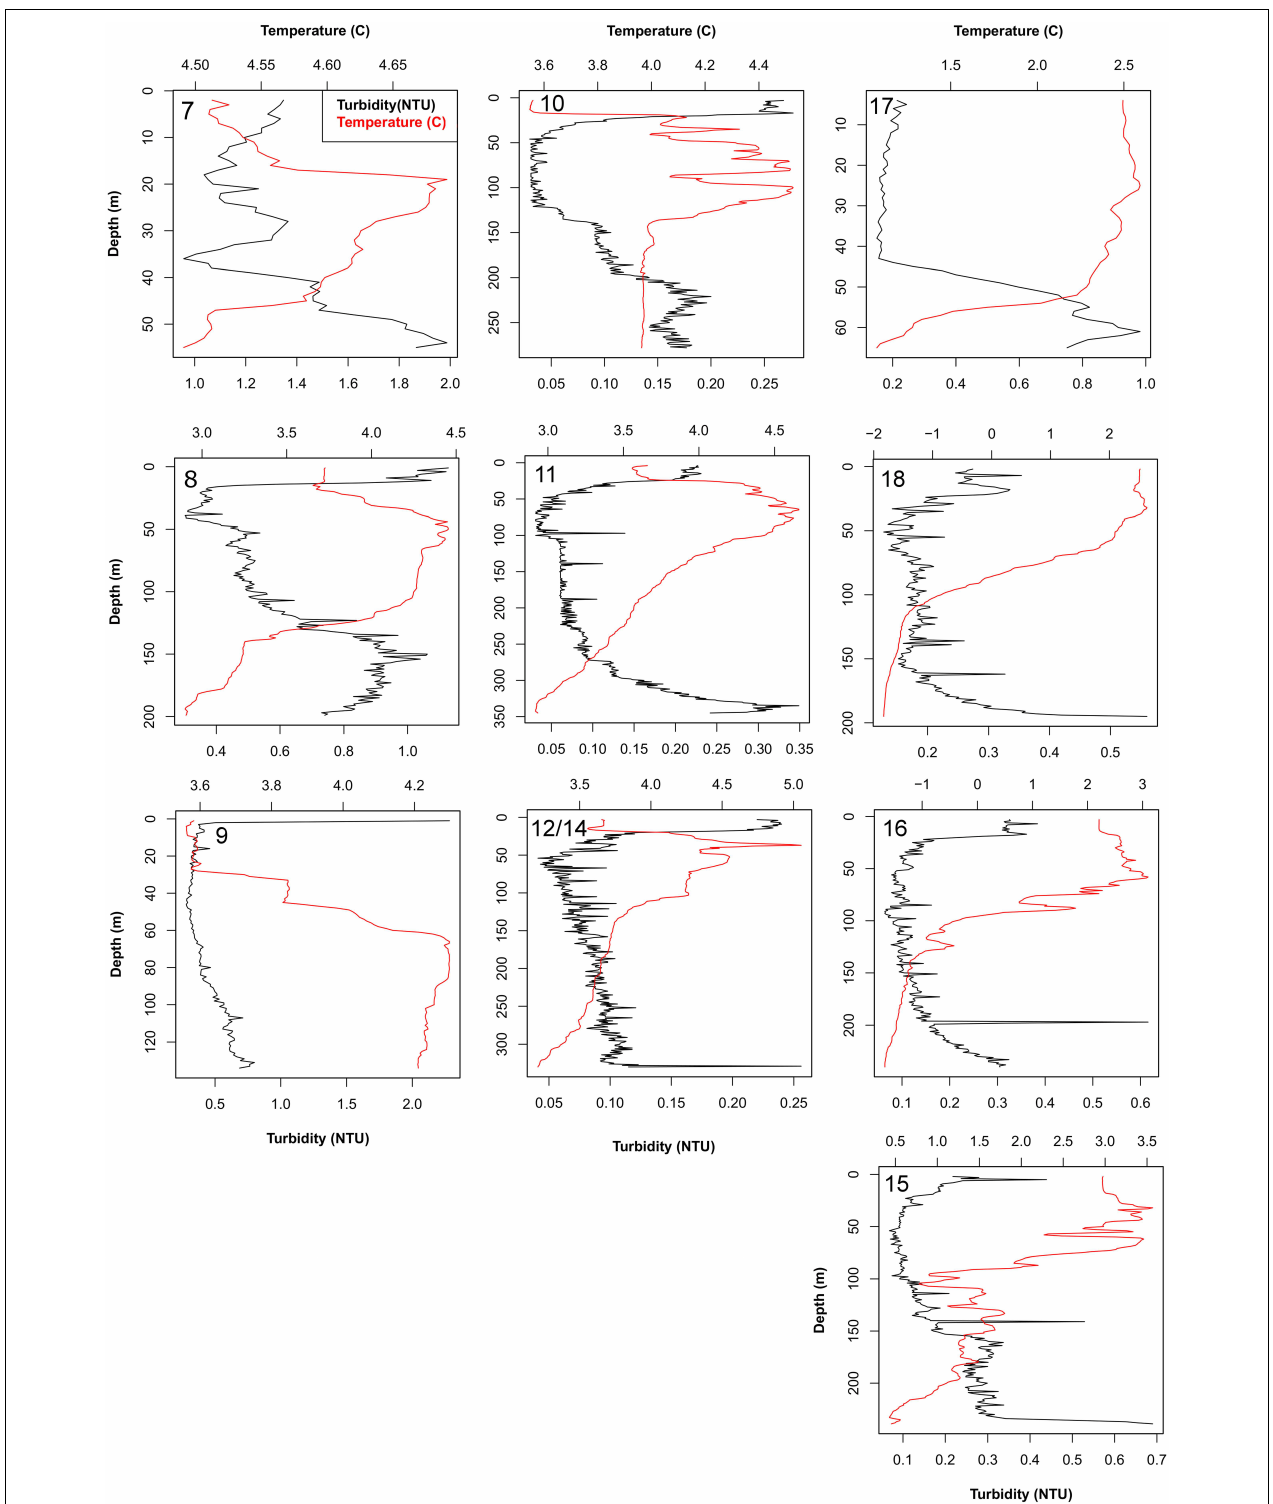
FIGURE 3 | CTD profiles showing temperature and turbidity of the water at each station. Numbers in bold indicate station. Note different scales of x - and y -axes.